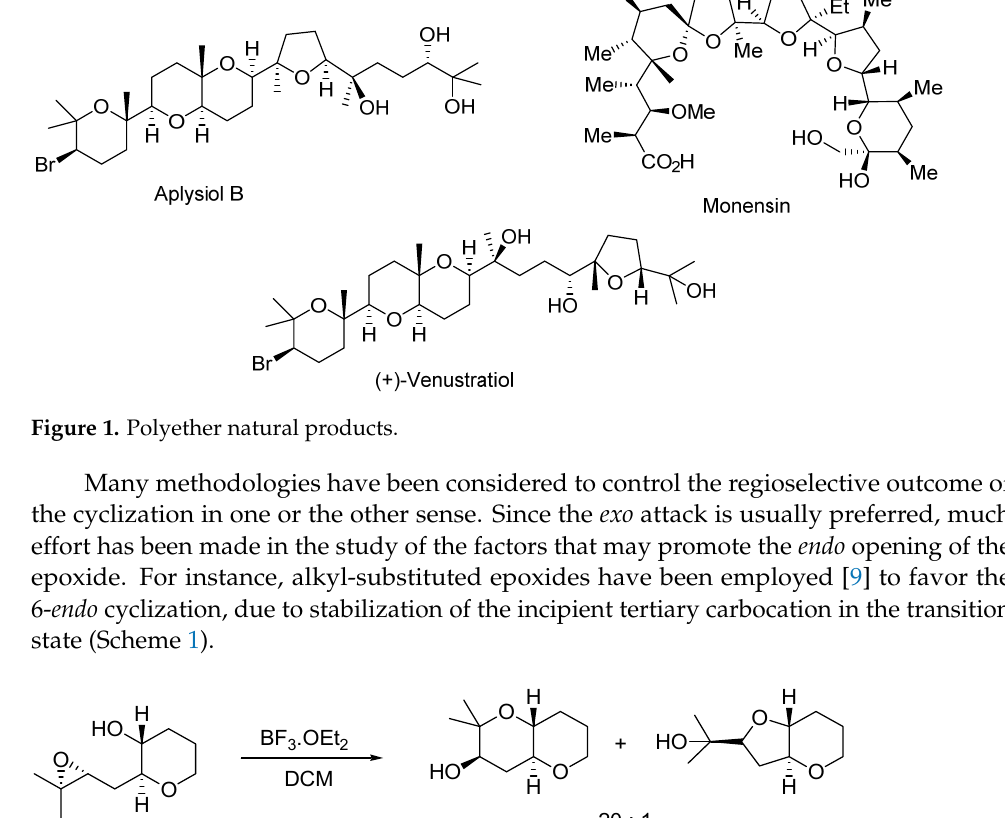
Figure 1. Polyether natural products.